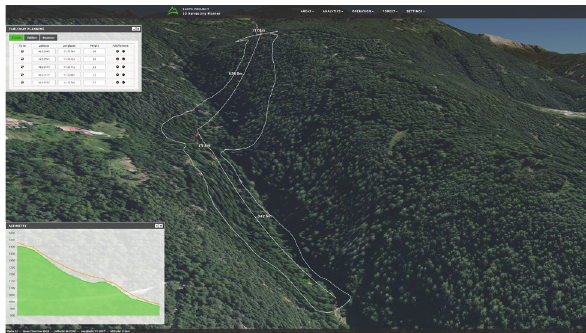
Figure 12: Cableway placement and harvesting area